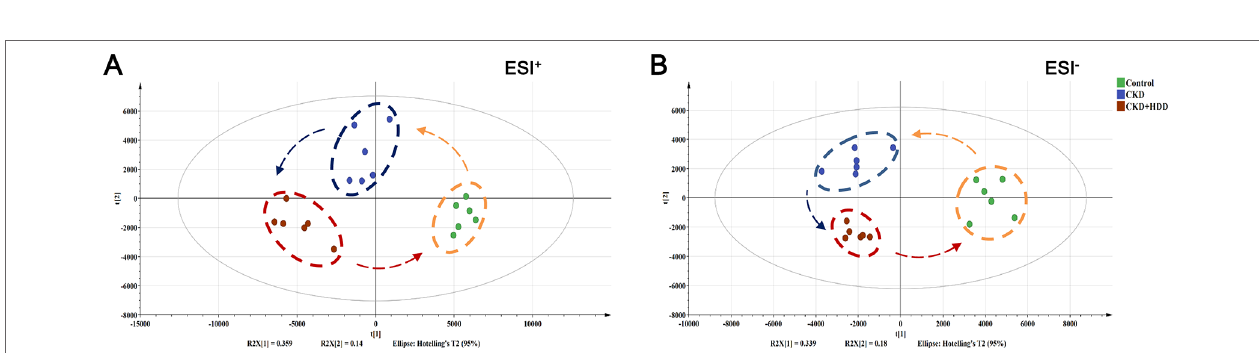
FIGURE 5 | Disordered pathways in the CKD group. The topology map generated from MetaboAnalyst described the impact of 28 metabolites identified between control and CKD groups on metabolic pathway.